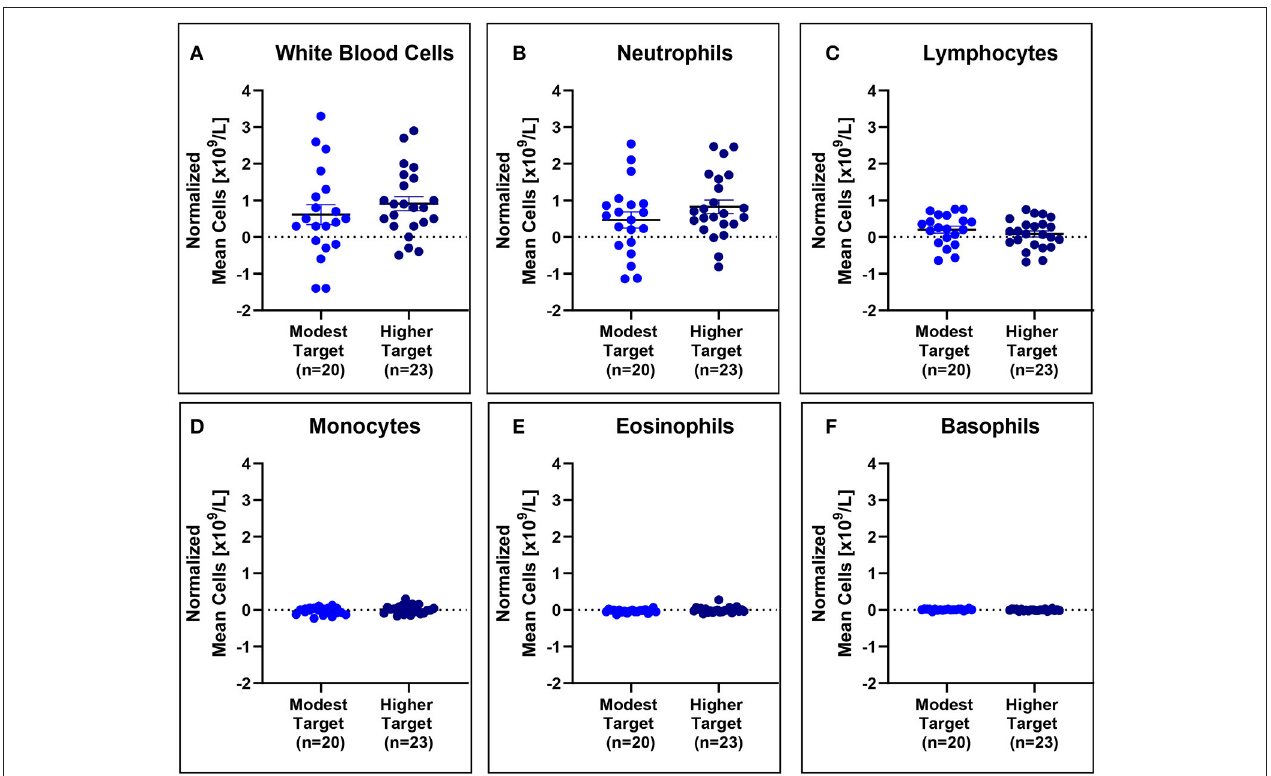
FIGURE 6 | White blood cell counts are comparable for modest and higher target allergics. No significant differences were observed in change in white blood cell (A) , neutrophil (B) , lymphocyte (C) , monocyte (D) , eosinophil (E) , and basophil (F) counts normalized to baseline in the peripheral blood post-exposure for allergics exposed to a higher vs. modest HDM target.